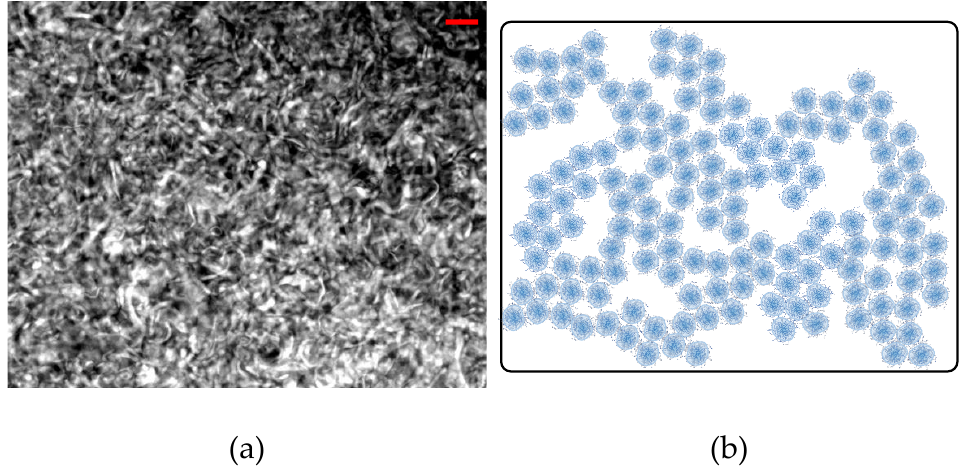
Figure 15. ( a ) Fluorescence image of sample M0 at 0.7% wt of Carbopol (scale bar, reported in red, of 150 µ m); ( b ) cartoon of the structure observed in the absence of crystals at the same concentration. Note that a similar structure is observed for fresh or regenerated samples containing mannitol (i.e., in the absence of